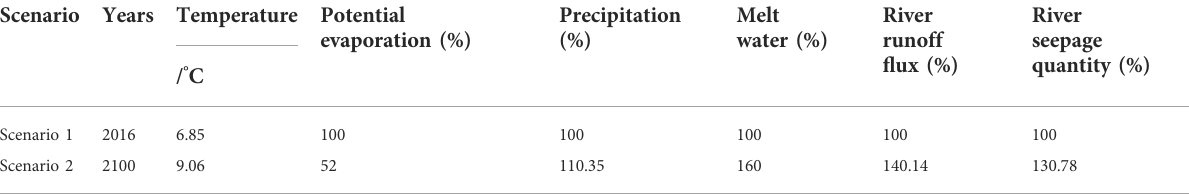
TABLE 1 Meteorological and hydrological scenarios for groundwater modelling. Scenario Years Temperature Potential evaporation (%)